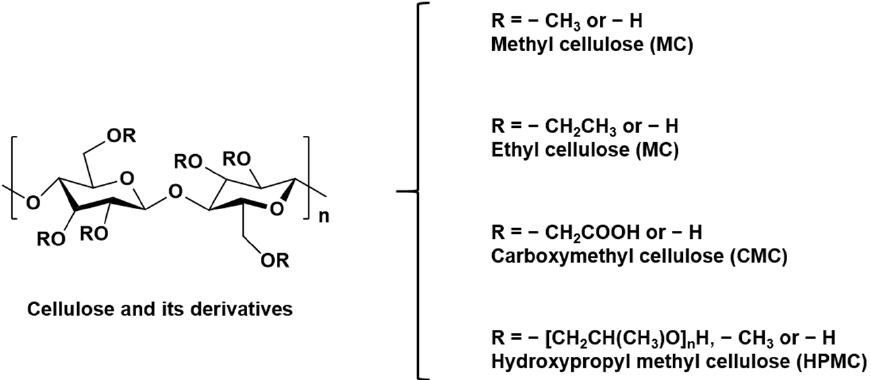
Figure 5. The structural formula of methyl cellulose (MC), ethyl cellulose (EC), carboxymethyl cellulose (CMC) and hydroxypropyl methyl cellulose (HPMC).